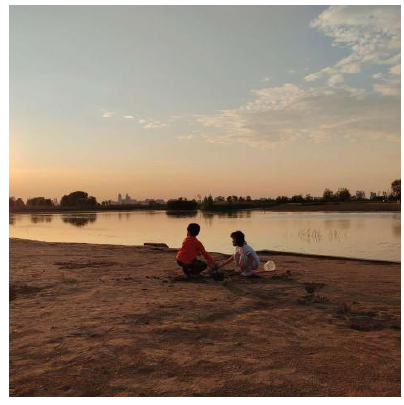
Fig. 1 Boys and girls can co-develop their abilities to lower gender